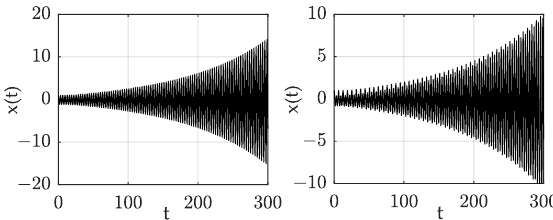
Figure 5. Response of point C, with F=0 ( left ) and F=1 ( right ). Figure 6. Response of point D, with F=0 ( left ) and F=1 ( right ). Figure 6. Response of point D, with F=0 ( left ) and F=1 ( right ).